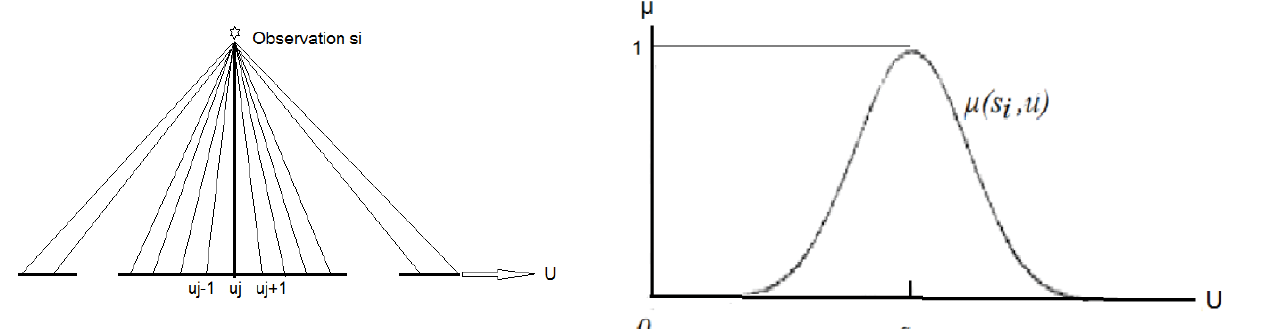
Fig. 3. The information diffusion function is used to diffuse infor- mation s i to all the elements of the universe of discourse U .